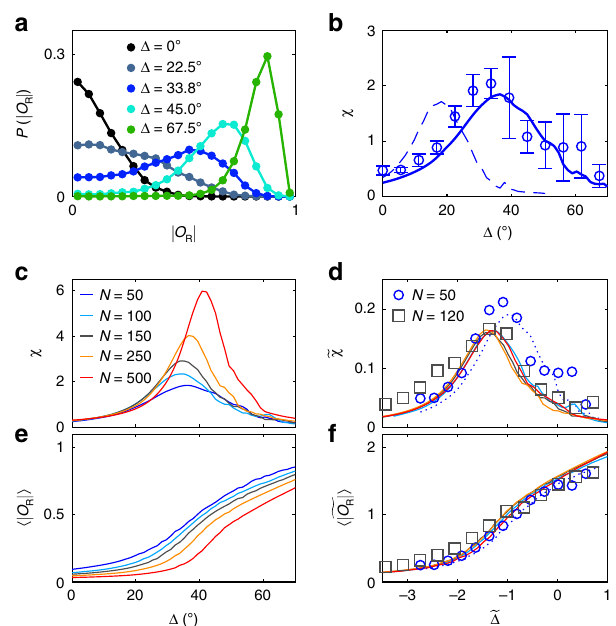
Fig. 4 Susceptibility and fi nite-size scaling. a Experimental probability distribution of the rotational order parameter | O R | for different values of Δ showing a continuous transition between a swarm (black) and a swirl (green) of a group of N = 50 APs. b Corresponding susceptibility χ as a function of the deviation angle Δ (symbols). Error bars correspond to the standard deviation obtained from different measurements. Lines correspond to simulations where D R,sim is identical (dashed) and three times larger (solid) compared with the experimental value D R,exp = 0.0028s − 1 . c χ vs. Δ obtained from simulations for different particle numbers N = [50, 100, 150, 250, 500] and D = 3 D χ ¼ χ (cid:2) N (cid:3) γ = ν vs. the R,sim R,exp . d Corresponding rescaled susceptibility e (cid:2) N 1 = ν . The critical exponents ν , γ and the rescaled deviation angle e Δ ¼ Δ (cid:3) Δ c Δ c value of Δ c were used as free fi tting parameters. The best data collapse is j jh i vs. Δ for simulations achieved for ν = 3.87, γ = 2.24 and Δ c = 56.15°. e O R with N = [50, 100, 150, 250, 500]. f Corresponding rescaled order parameter ~ Δ with β as a free fi tting parameter ( ν and Δ g O R j jh i ¼ O R j jh i (cid:2) N β = ν vs. c were taken from d ). Best collapse is achieved for β = 0.66. Symbols in d and f show experimental data for N = 50 and N =